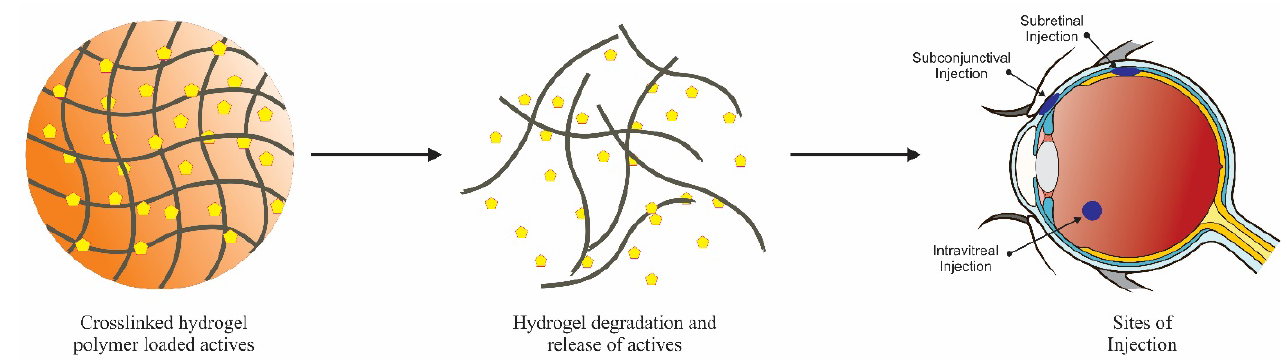
Figure 6. Different targets and potential ocular delivery routes available for drug-loaded hydrogel